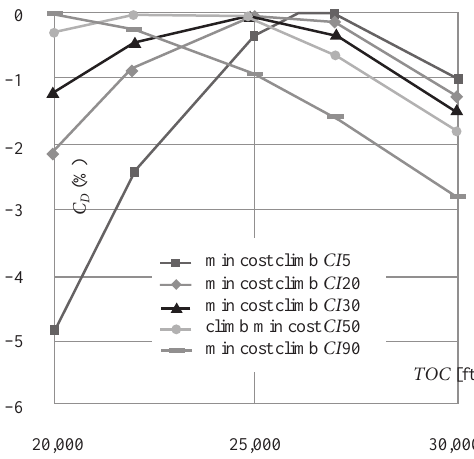
Fig. 14. The change of Δ C D with TOC , for minimum cost climb technique, m c 1 = 61,000